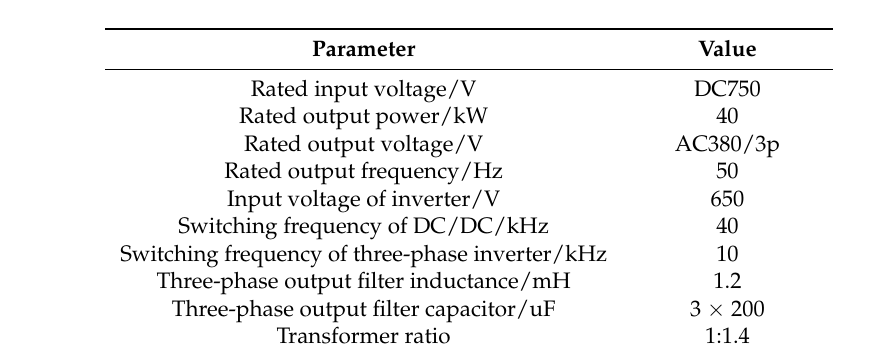
Figure 1. Circuit topology. Table 1. System parameters.